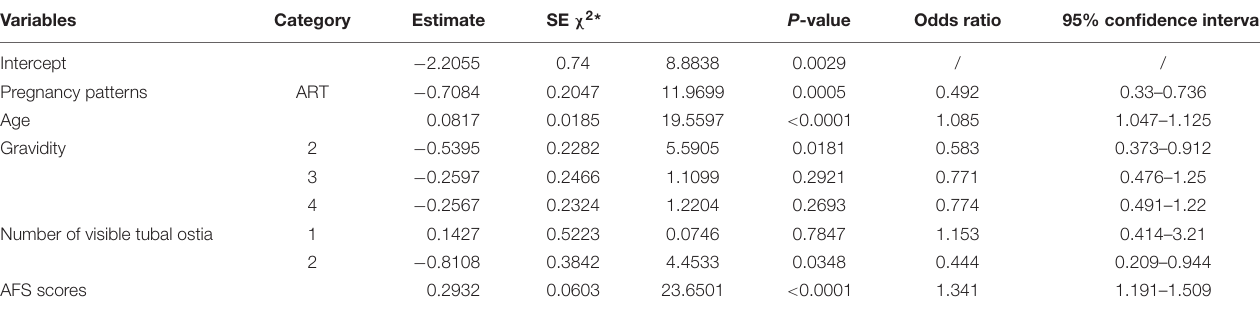
TABLE 3 | Full logistic regression of significant variables in the live birth and non–live birth